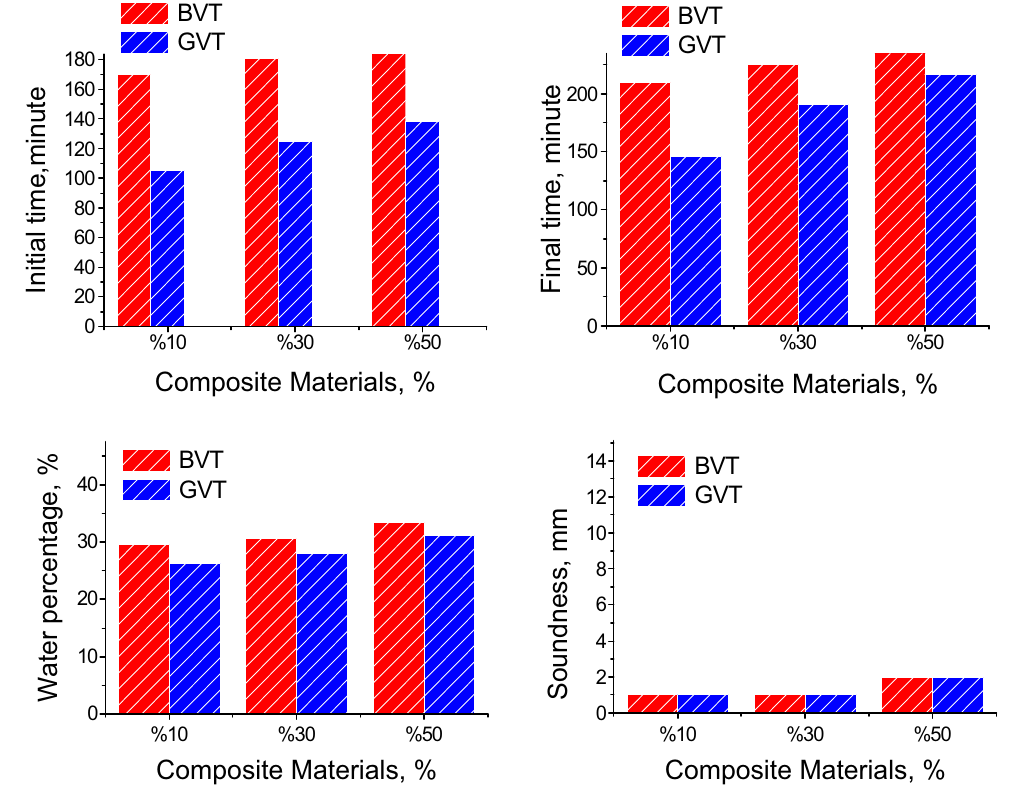
Figure 9: The hydration properties of the blended